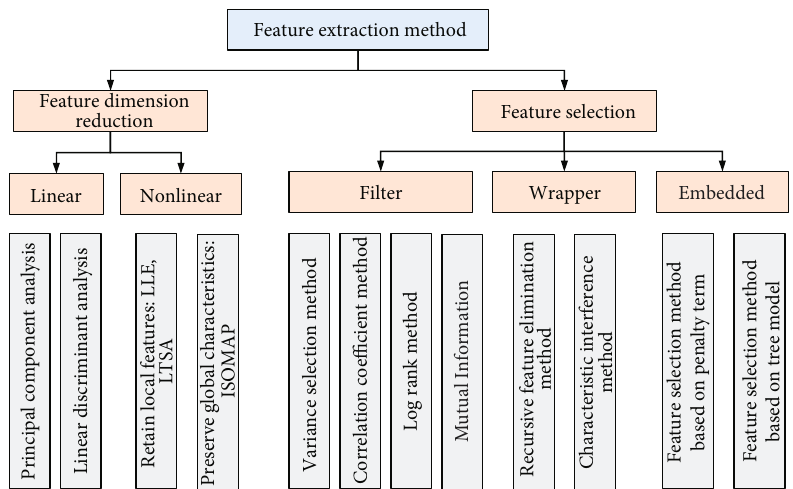
Figure 3: The feature extraction